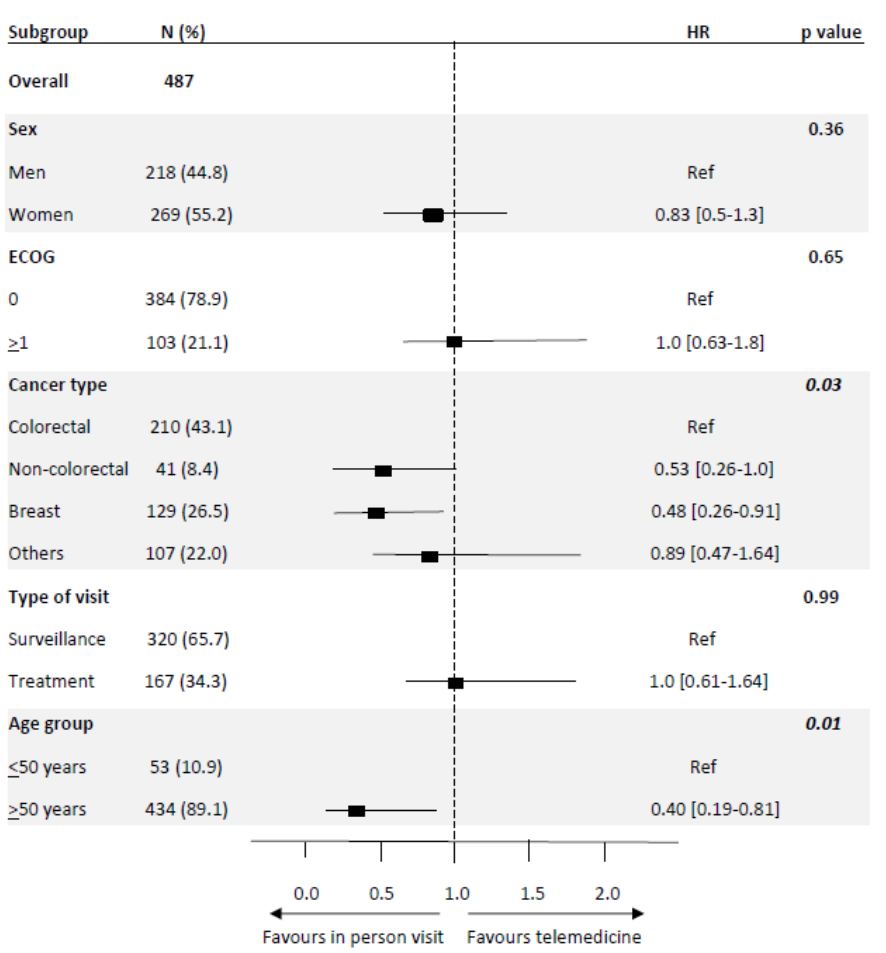
Figure 4. Multivariate logistic regression to assess predictors of telemedicine use willingness in the future. Q4: In the future, would you accept switching some in-person to virtual visits?